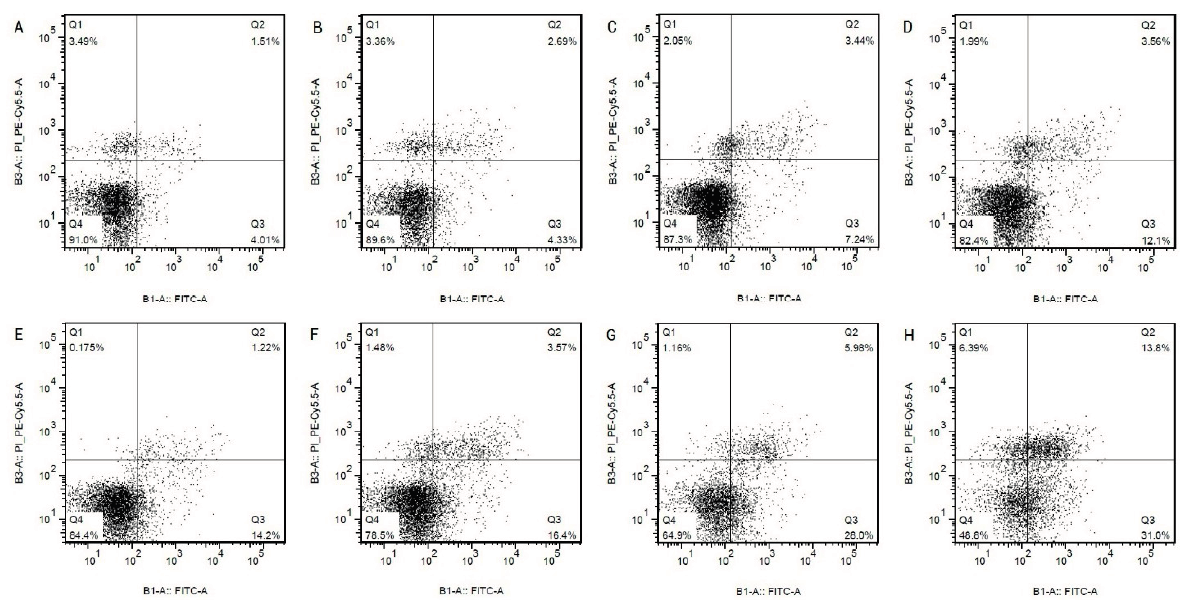
Figure 2. The apoptosis rate of different concentrations Hcy induced on HCAECs by flow cytometry in each group. The time of treatment was 24 h. ( A – H ), respectively, on behalf of the control group, Hcy 0.1 mmol/L group, Hcy 0.3 mmol/L group, Hcy 0.6 mmol/L group,